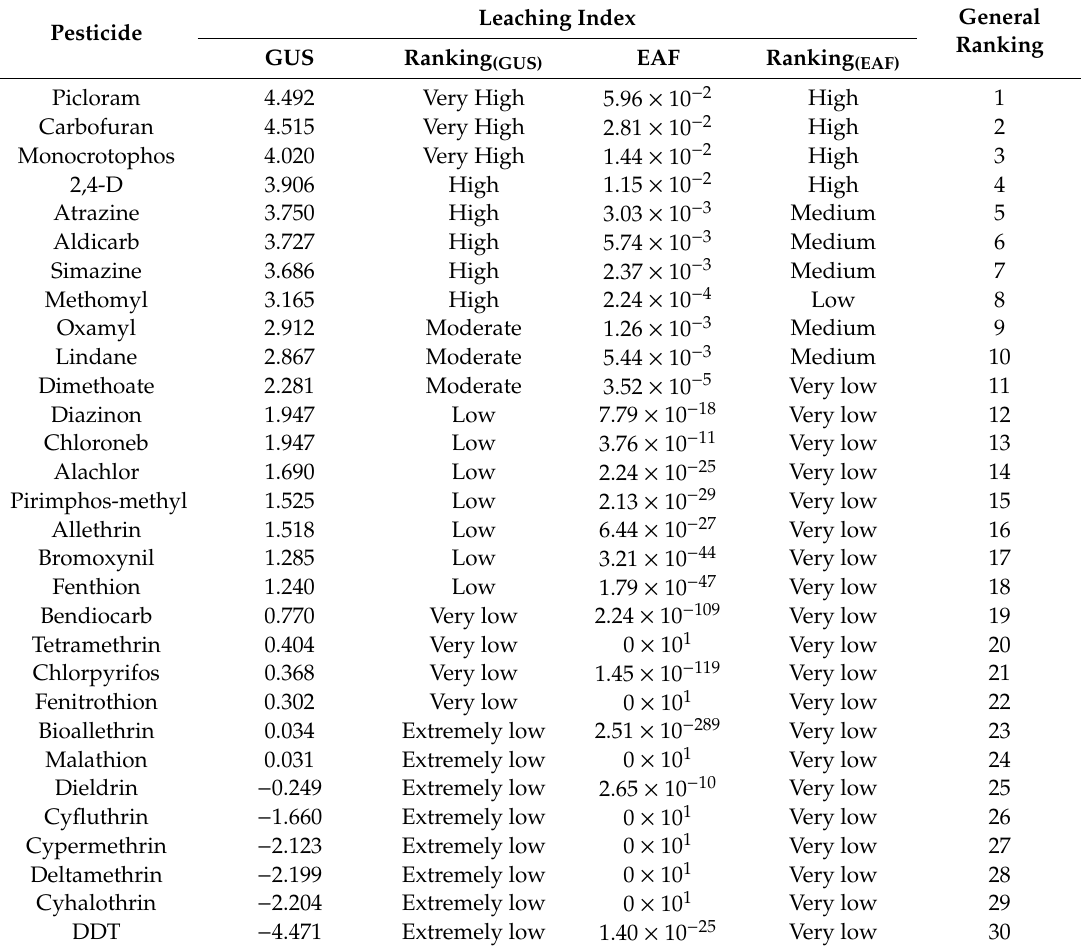
Table 6. General rankings of leaching potential of pesticides in Jazan watershed as calculated by a combined assessment using the GUS indicator and EAF index